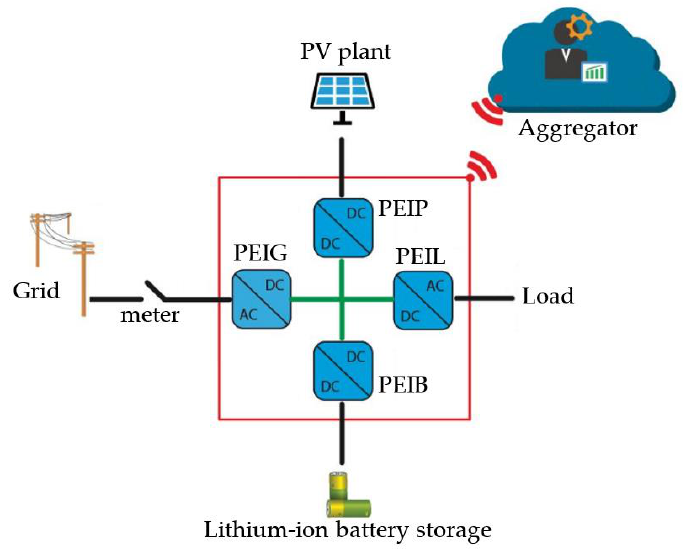
Figure 3. The grid-connected nanogrid for home application for PV-batteries hybrid systems.